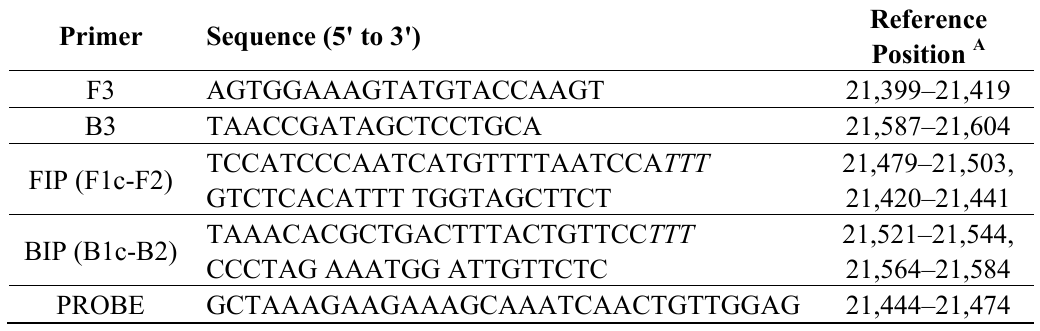
Table 1. Primers and probes used in the assay and its corresponding location to the gene.